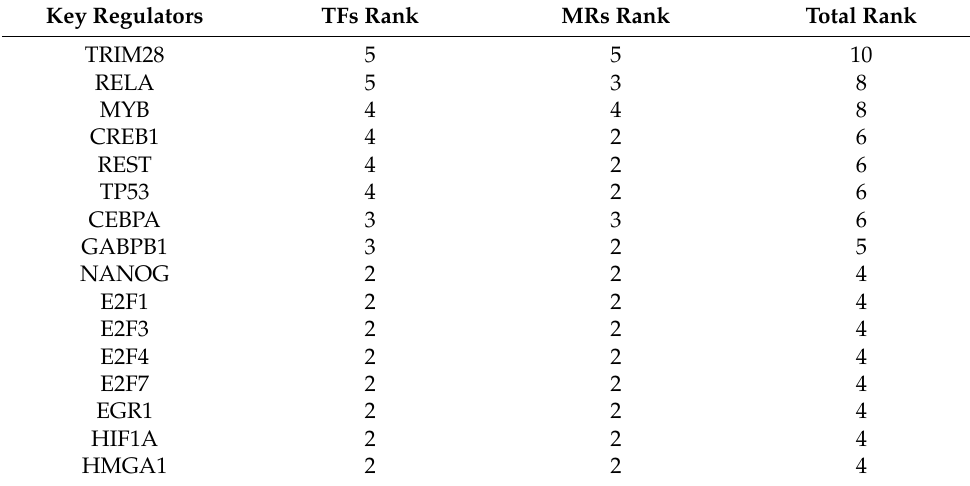
Table 2. Molecular key regulators of CD133 revealed by in silico analysis. Final list of molecular key regulators (KRs), ranged by their total rank (maximal rank—12). Ranks of KRs were calculated by summing up the ranks of corresponding transcription factors (TFs) and master regulators